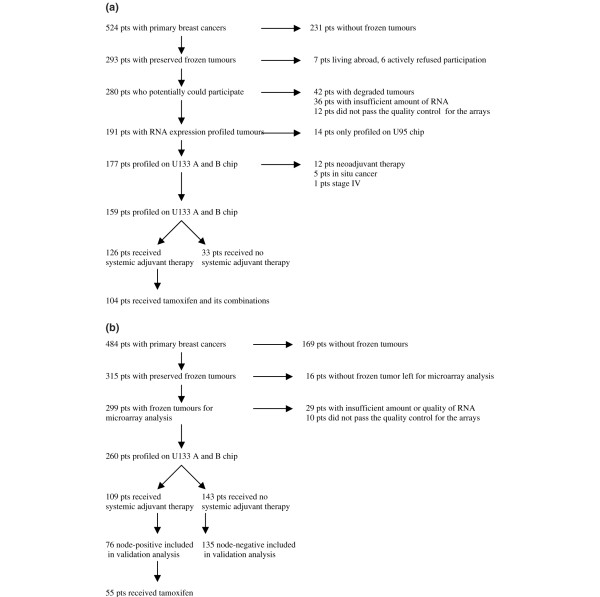
Description of exclusion criteria for all patients (pts) operated on for primary breast cancer at (a) Karolinska Hospital, 1994–1996 and (b) Uppsala University Hospital, 1987–1989.